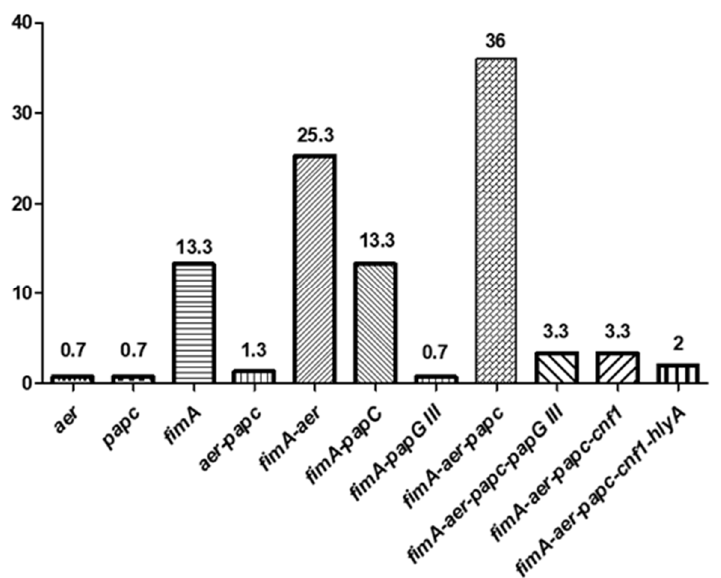
Figure 1. The co-occurrence (percentages) of several virulence factors (VFs) in ESBL-producing E. coli .